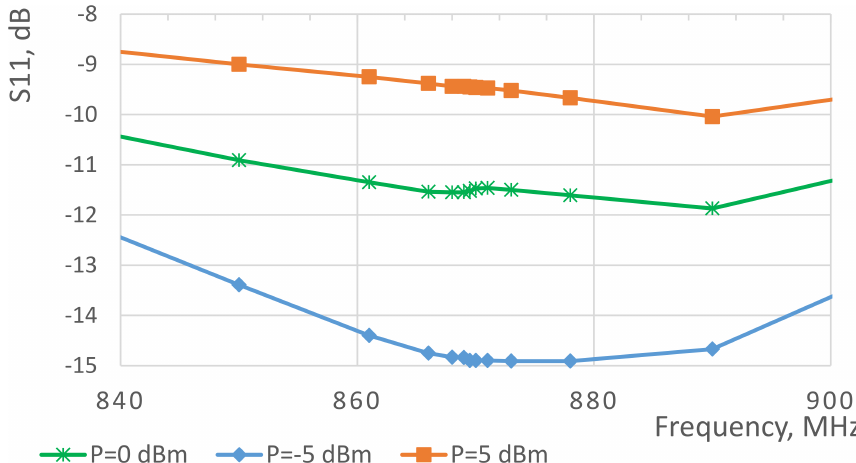
Figure 12. Measured S11 parameter of the radio frequency to direct current converter board for different input power